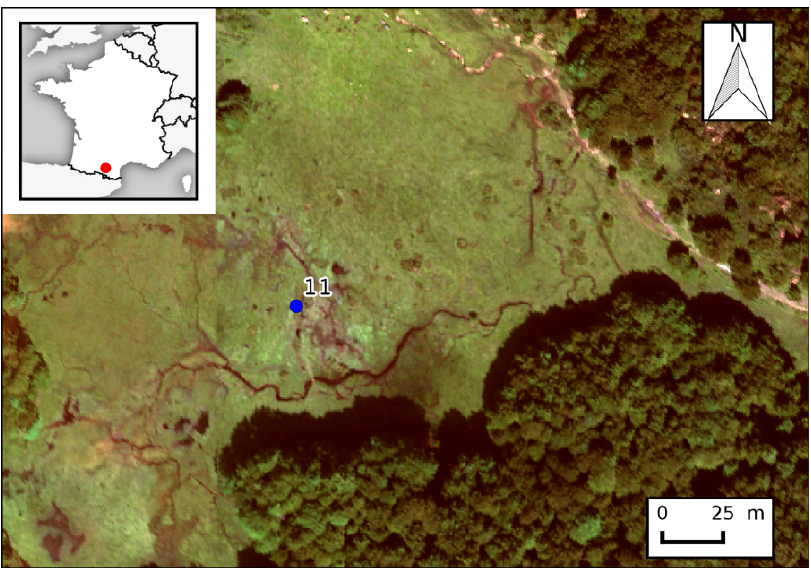
Figure A9. Location of the in situ spectroradiometer measurements for the plots of Menyanthes trifoliata (METR).